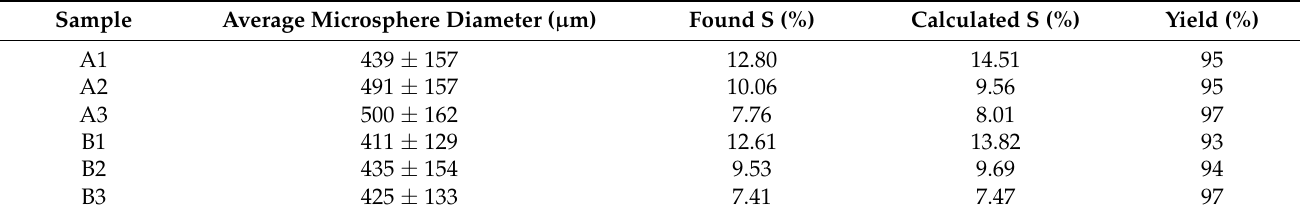
Table 3. Microsphere size, calculated and measured sulfur content, and